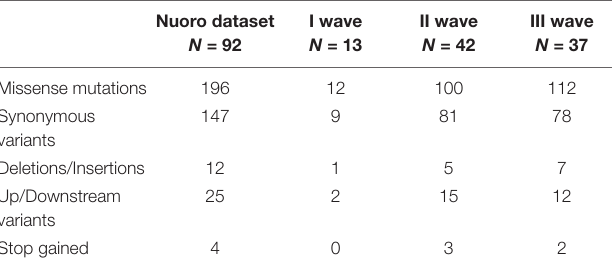
TABLE 2 | Mutation types per wave.